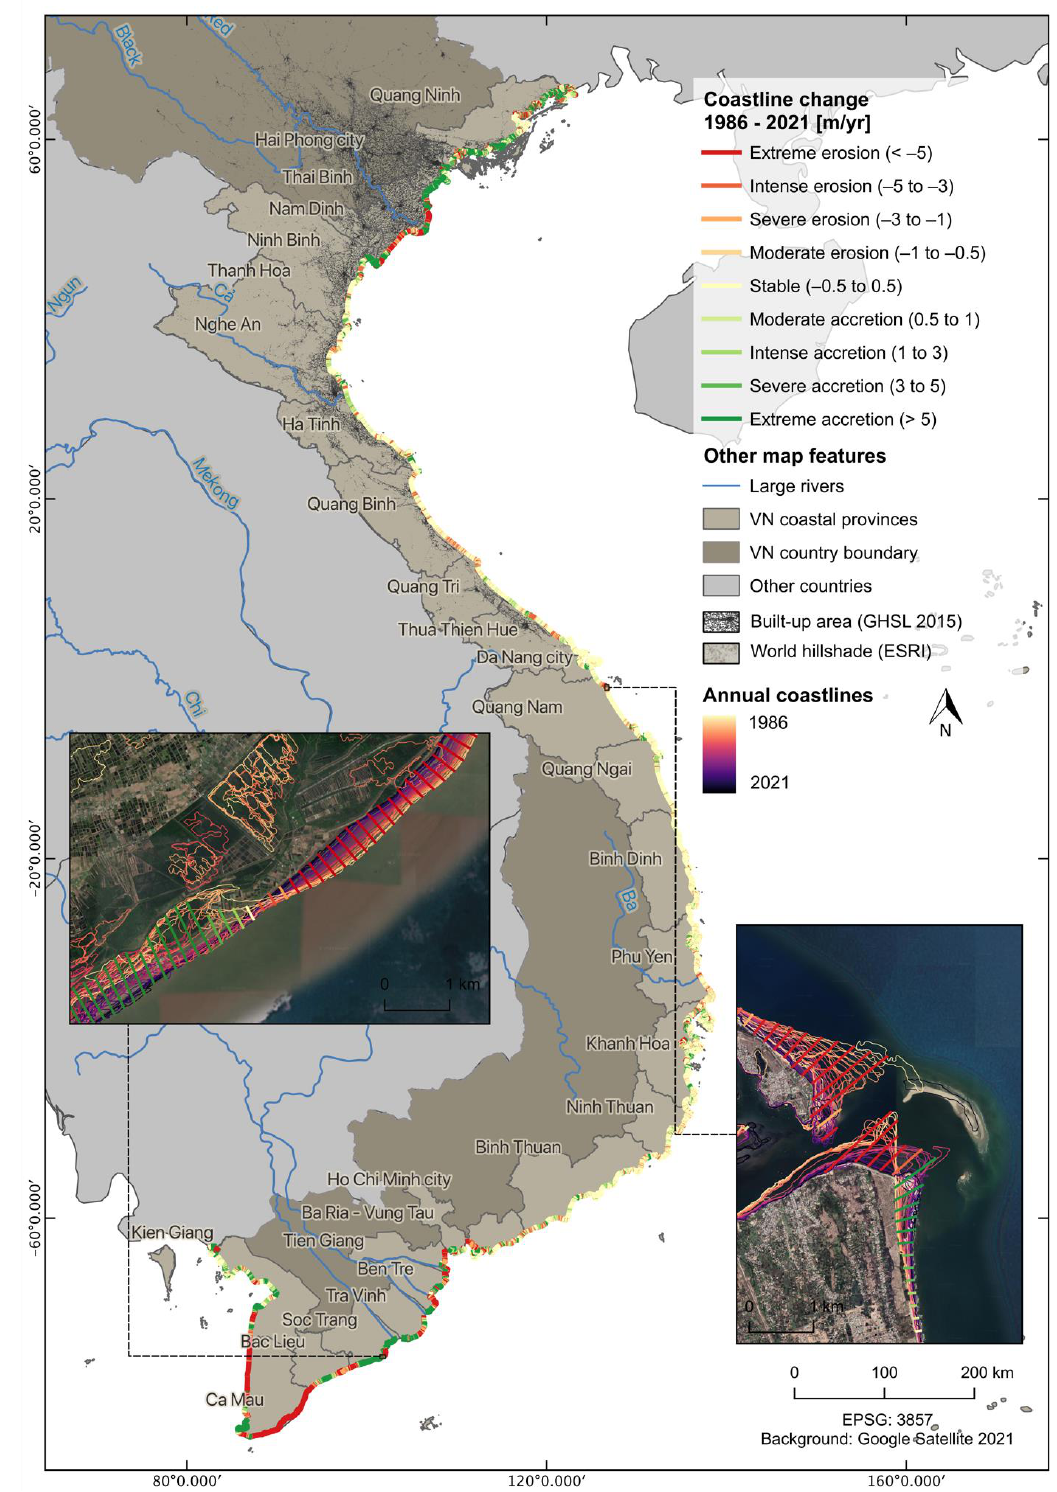
Figure 7. Classification of coastline change in Vietnam from 1986 to 2021, with zooms on two exem- plary coastal segments showing the annual coastlines overlaid by the classification transects.